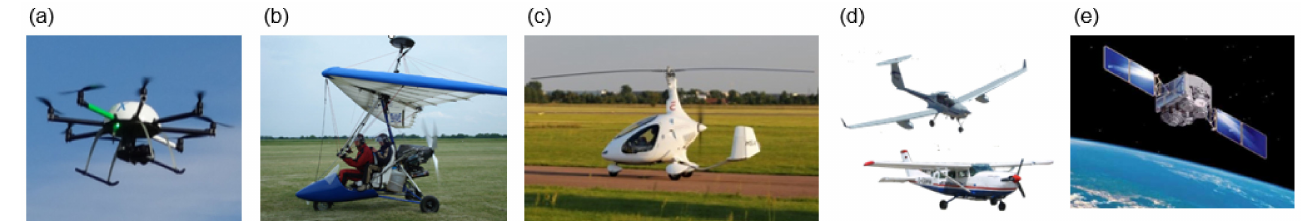
Figure 4. Different air- and spaceborne remote-sensing platforms for assessing geomorphodiversity, geomorphic traits, their changes and disturbances: ( a ) unmanned aerial vehicles (UAV or drone), ( b ) microlight—gravity-controlled; ( c ) gyrocopter or microlight helicopter; (( d )—top) ECO-Dimona; (( d )—bottom) Cessna and ( e ) satellite (from Lausch et al.